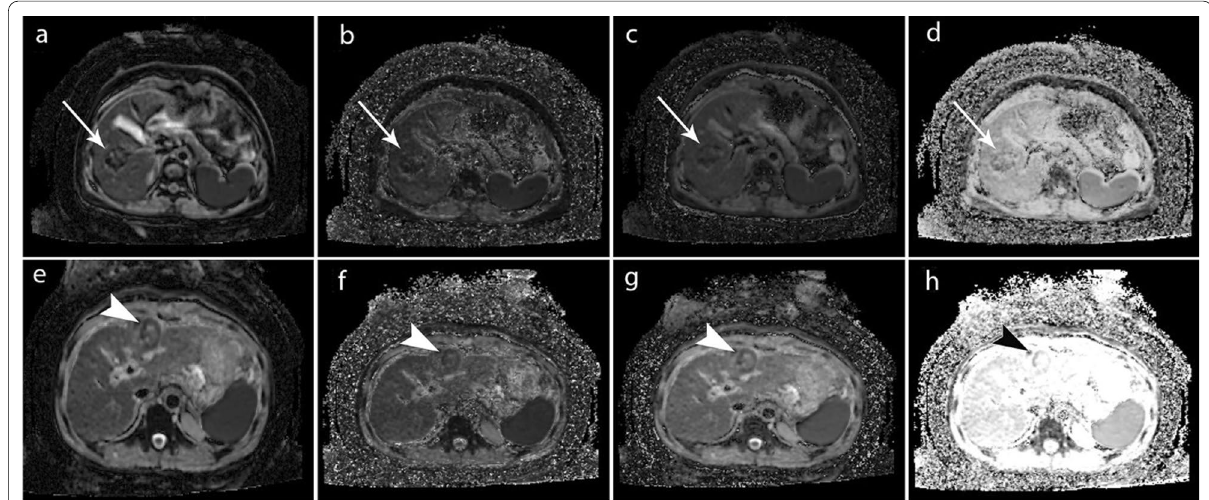
Fig.1 Pretreatment MR images of two patients with responded and nonresponded lesions to TACE. a – d Pretreatment MR Images on the same slice of one lesion in segment eight and right lobe of the liver in a 40-year-old woman who did show tumor response to TACE. a – d IVIM-ADC, D, D*, and f maps, with the arrow showing the HCC lesion on the same slice with mean ADC, D, D*, and f values of 0.92 0.97 10 3 mm 2 /s, and 3.53 10 3 mm 2 /s, respectively. e – h Pretreatment MR Images on the same slice of one lesion in segment four and right × − × − lobe of the liver in a 40-year-old man who did not show tumor response to TACE. e – h IVIM-ADC, D, D*, f maps, with the arrowhead showing the HCC lesion on the same slice with mean ADC, D, D*, and f values of 0.9 mm 2 /s, respectively